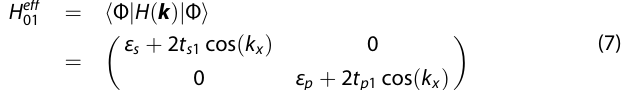
The edge zero states are Fermi arcs that linking the pair of ; 0 Þ . Once H 0 ð k Þ included, the effective projected Dirac points ð ± k D x (01)-edge Hamiltonian is,